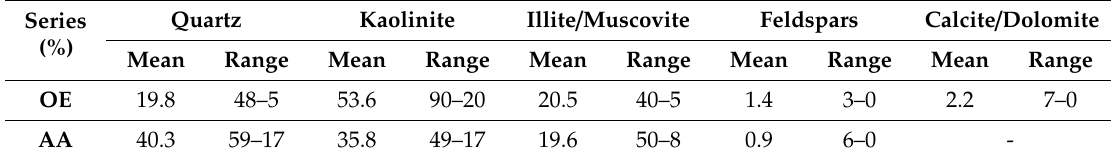
Table 1. Mineralogical composition of mine spoils (bulk mine spoil). Mean value of the 60 samples analyzed, and range for each series (40 Oliete-Estercuel (OE) samples and 20 Ariño-Andorra (AA) samples).